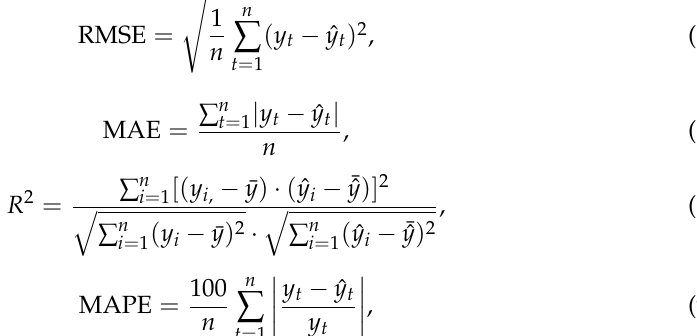
( R 2 ), and mean absolute percentage error (MAPE).